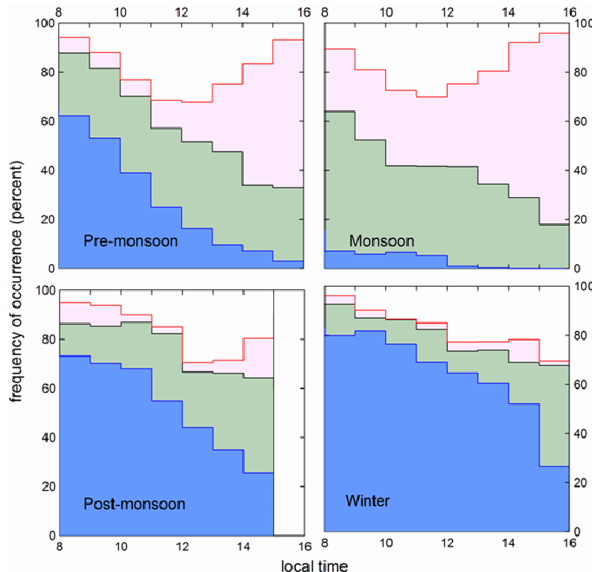
Fig. 3. Frequency of occurrence of clear skies (light blue), thin/moderate clouds (grey), thick clouds (pink), and scattered clouds (white) versus time of day for the different seasons, as de- rived from the CMP21